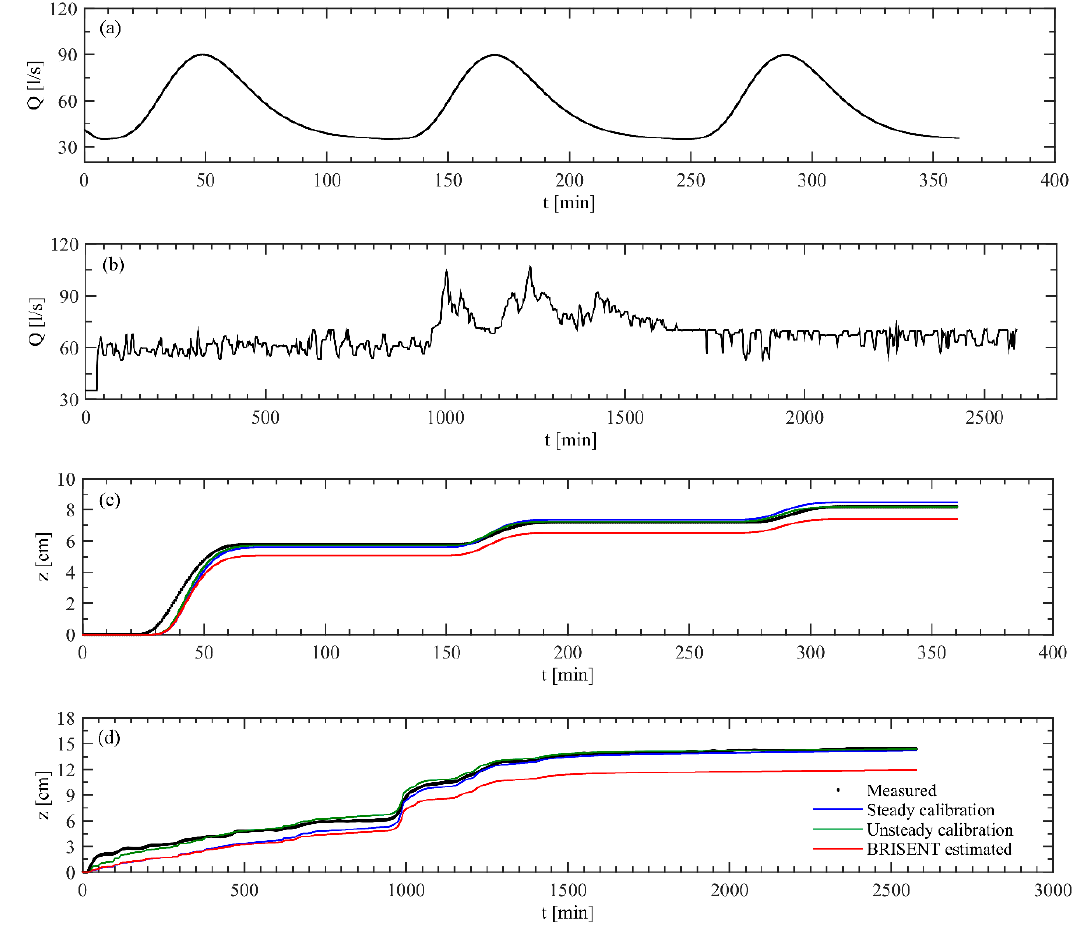
Figure 7. Validation of the BRISENT model with highly unsteady experiments. Images ( a , b ) are experiments 2017LINK01U and 2017LINK02U, respectively. Images ( c , d ) present measured scour depths over time, BRISENT model calibrated using a steady run, BRISENT model calibrated using unsteady runs, and BRISENT model considering Equation (13) to Equation (14) and Equation (19) to Equation (22) for experiments 2017LINK01U and 2017LINK02U,